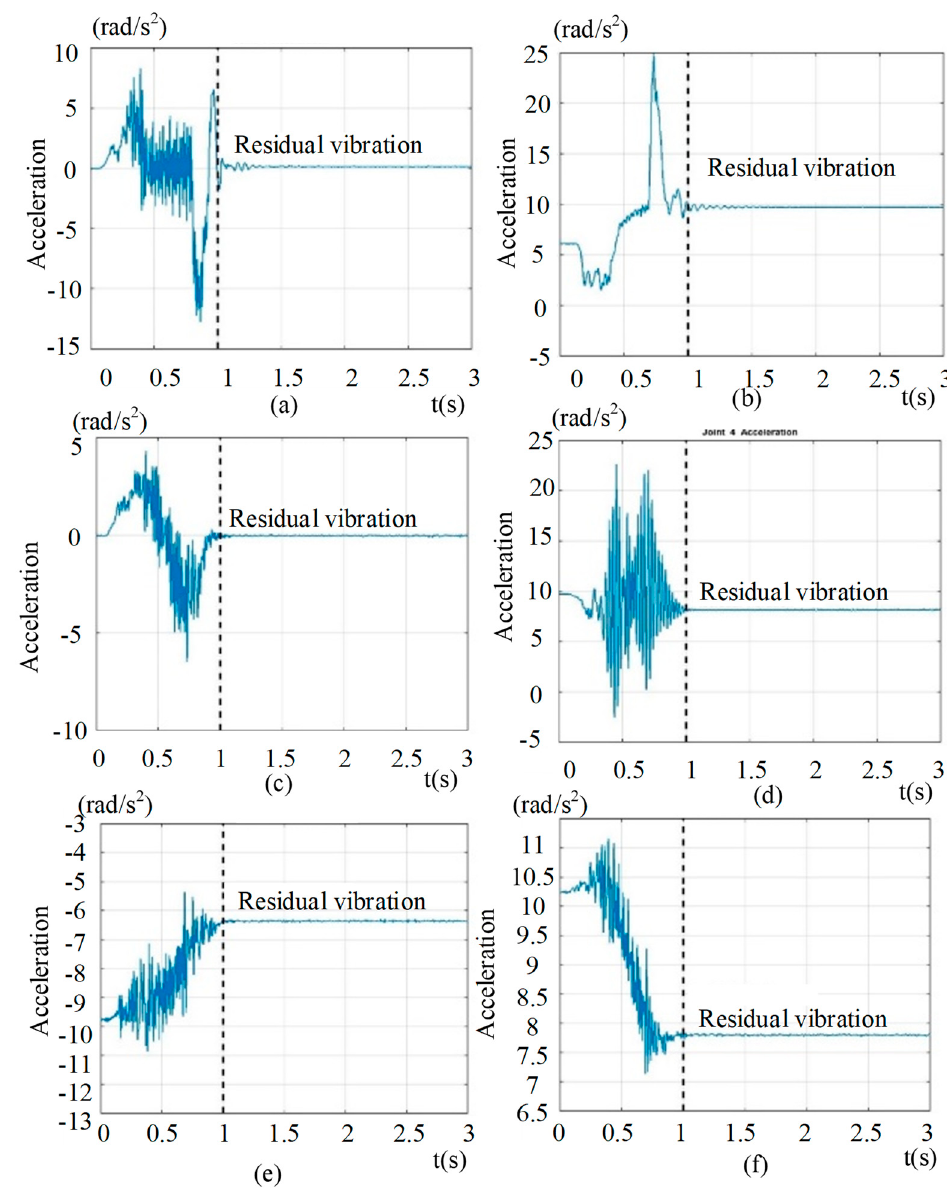
Figure 9. Experimental acceleration data for joints 1 to 6 rotate in the CW direction. ( a ) Joint 1. ( b ) Joint 2. ( c ) Joint 3. ( d ) Joint 4. ( e ) Joint 5. ( f ) Joint 6.